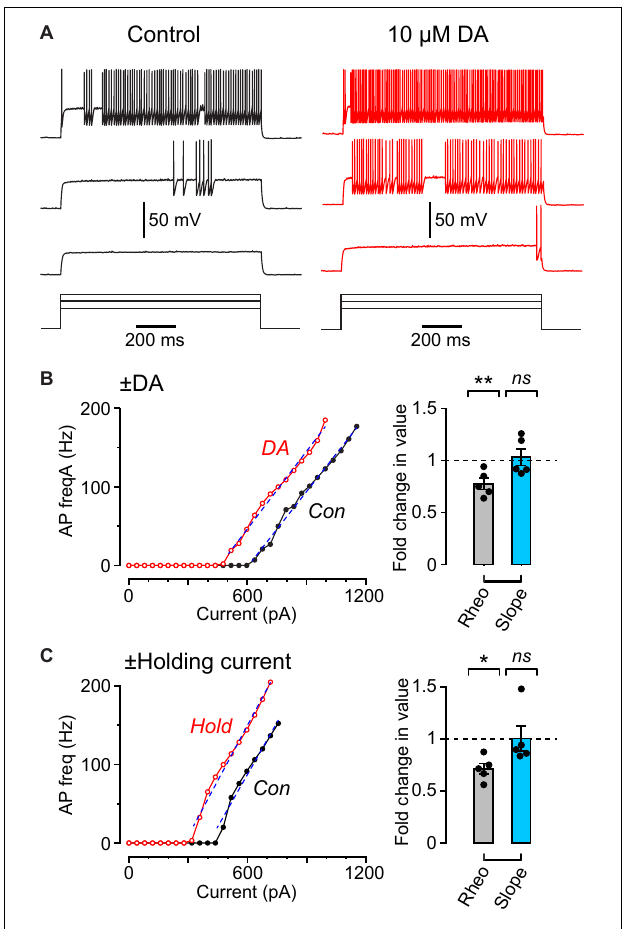
FIGURE 3 | Dopamine causes a leftward shift in the f-I plot with no change in slope, similar to the effect of injecting a steady holding current. (A) V m traces recorded in response to three 1 s-long current steps (480, 640, 800 pA) in the same FS cell in control (black traces, left) and in 10 µ M DA (red traces, right). (B) (Left), Plot of AP frequency vs. injected current (f-I plot) for the same cell shown in (A) . Superimposed dashed lines are linear fits over the indicated ranges. (B) (Right), Summary plot showing the fold change in rheobase (‘Rheo’) and slope of the f-I plot (‘Slope’) caused by 10 µ M DA, calculated by dividing the value for each cell in DA by the corresponding value for that cell in control conditions. Filled symbols are measurements from individual neurons ( n = 5 FS cells). Bar plots and error bars indicate the mean ± SEM. (C) Results from a similar experiment in which, instead of perfusing dopamine, a steady holding current was applied, sufficient to depolarize the cell by ∼ 3 mV. Data are from a different sample of FS cells ( n = 5) from the cells shown in (B) . ** p < 0.01; * p ± 0.05; ns , not significant.